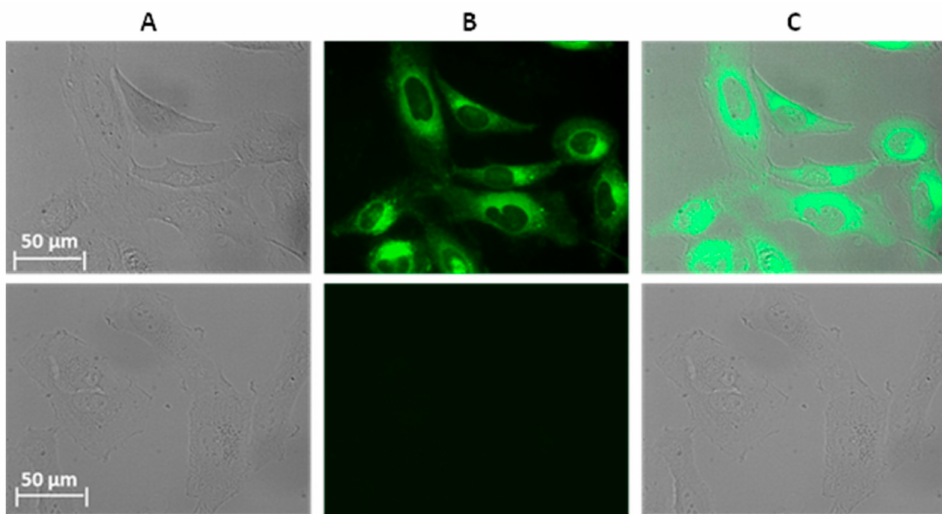
Figure 1. Images obtained from epifluorescence microscopy experiments on living HeLa cells. (Top) after 1 h and 30 min of incubation with 30 µ M solution of the 3a fluorescent probe. (Bottom) Untreated cells as a control. ( A ) Brightfield. ( B ) Fluorescence. λ ex : 485 nm band pass 20 nm filter, λ em : 525 nm band pass 50 nm, τ exp : 300 ms. ( C ) Merged. 40 × objective.